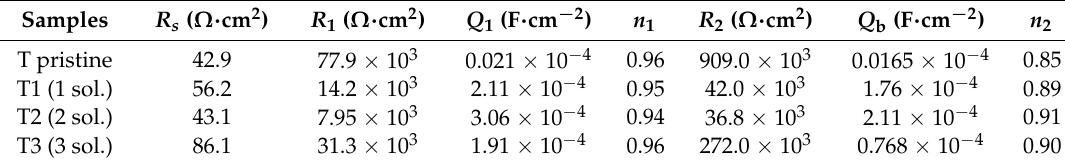
Figure 5. Equivalent circuit model used by [29]. Table 3. Values of equivalent circuits obtained by Al-Mobarak and Al-Swayih